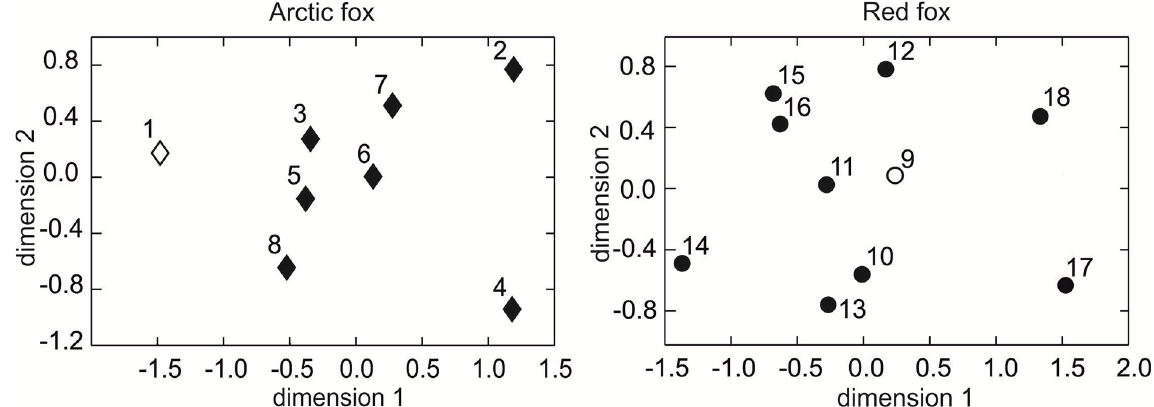
Fig 13. Distribution of the populations of the arctic and red foxes in a two-dimensional plane based on the morphotype variations of the first lower molar. Black rhomb–recent populations of the arctic fox, empty rhomb–fossil populations of the arctic fox, grey circle–recent populations of the red fox, empty circle–fossil population of the red fox. Information about the samples can be found in Table 1.